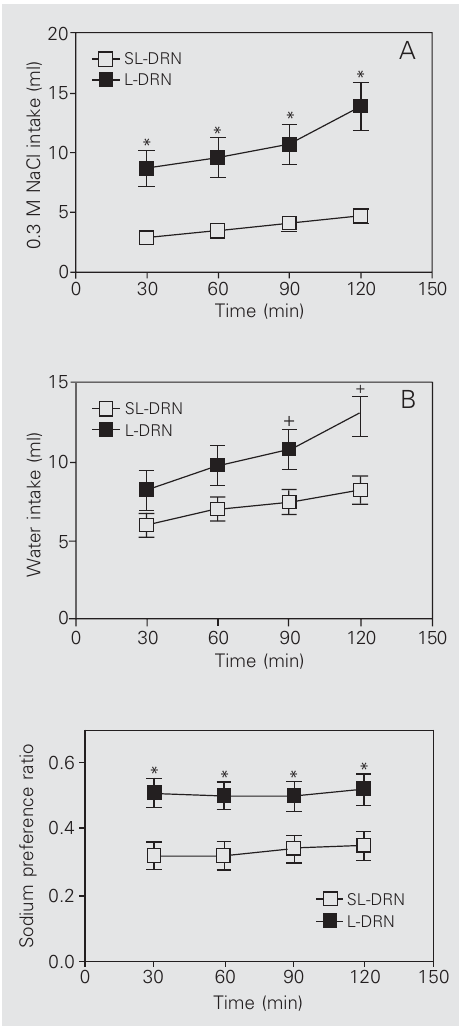
Figure 6. Sodium preference of dorsal raphe nucleus-lesioned (L- DRN, filled squares) and sham- lesioned rats (SL-DRN, open squares) submitted to sodium and water depletion induced by treatment with furosemide + captopril. Data are reported as means ± SEM. *P < 0.002 com- pared to the SL-DRN group (two- way ANOVA followed by the Newman-Keuls